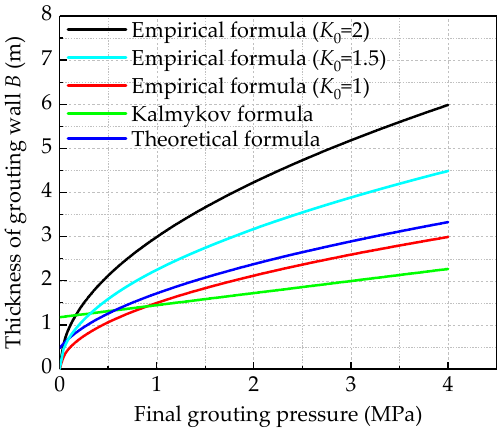
Figure 6. Relationship between the thickness of concrete retaining wall and grouting pressure.